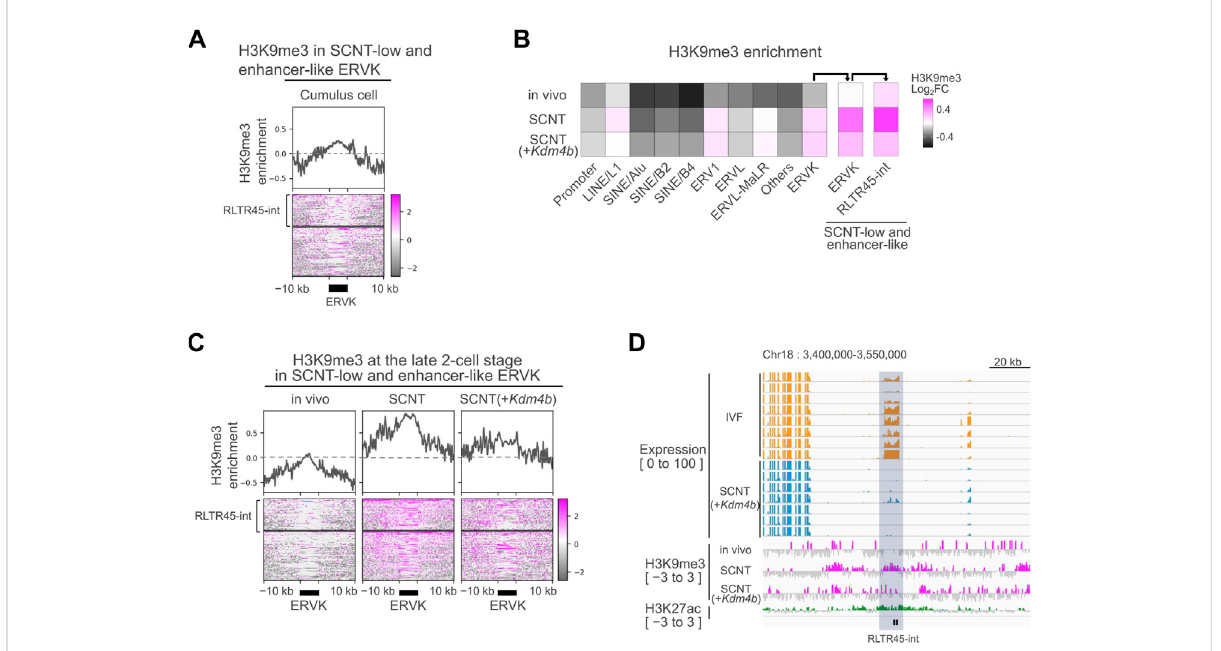
FIGURE 4 Donor cell-derived H3K9me3 was not fully reprogrammed at RLTR45-int loci. (A) Heatmap and line graph showing H3K9me3 enrichment at SCNT-low, enhancer-like ERVK loci in cumulus cells. The heatmap is divided into two parts: the upper represents the H3K9me3 enrichment of RLTR45-int loci and the lower represents that of the other ERVK loci. Published H3K9me3 ChIP-seq data (GSE70606) were analyzed. (B) Heatmap showing H3K9me3 enrichment of gene promoter, TE families, and SCNT-low, enhancer-like ERVK and RLTR45-int loci in 2-cell embryos. (C) Heatmap and line graph showing H3K9me3 enrichment at SCNT-low, enhancer-like ERVK loci in vivo , SCNT, and Kdm4b -mRNA-injected SCNT- derived 2-cell embryos. The heatmap is divided into two parts: the upper represents the H3K9me3 enrichment of RLTR45-int loci and the lower represents that of the other ERVK loci. (D) Genome browser view showing the expression levels in IVF (yellow) and SCNT (blue) morulae, H3K9me3 enrichment (red) in vivo , SCNT, Kdm4b -mRNA-injected SCNT 2-cellembryos, and H3K27acenrichment (green) in 8-cell in vivo embryos around two SCNT-low, enhancer-like RLTR45-int loci on chromosome 18. The RLTR45-int region is highlighted in